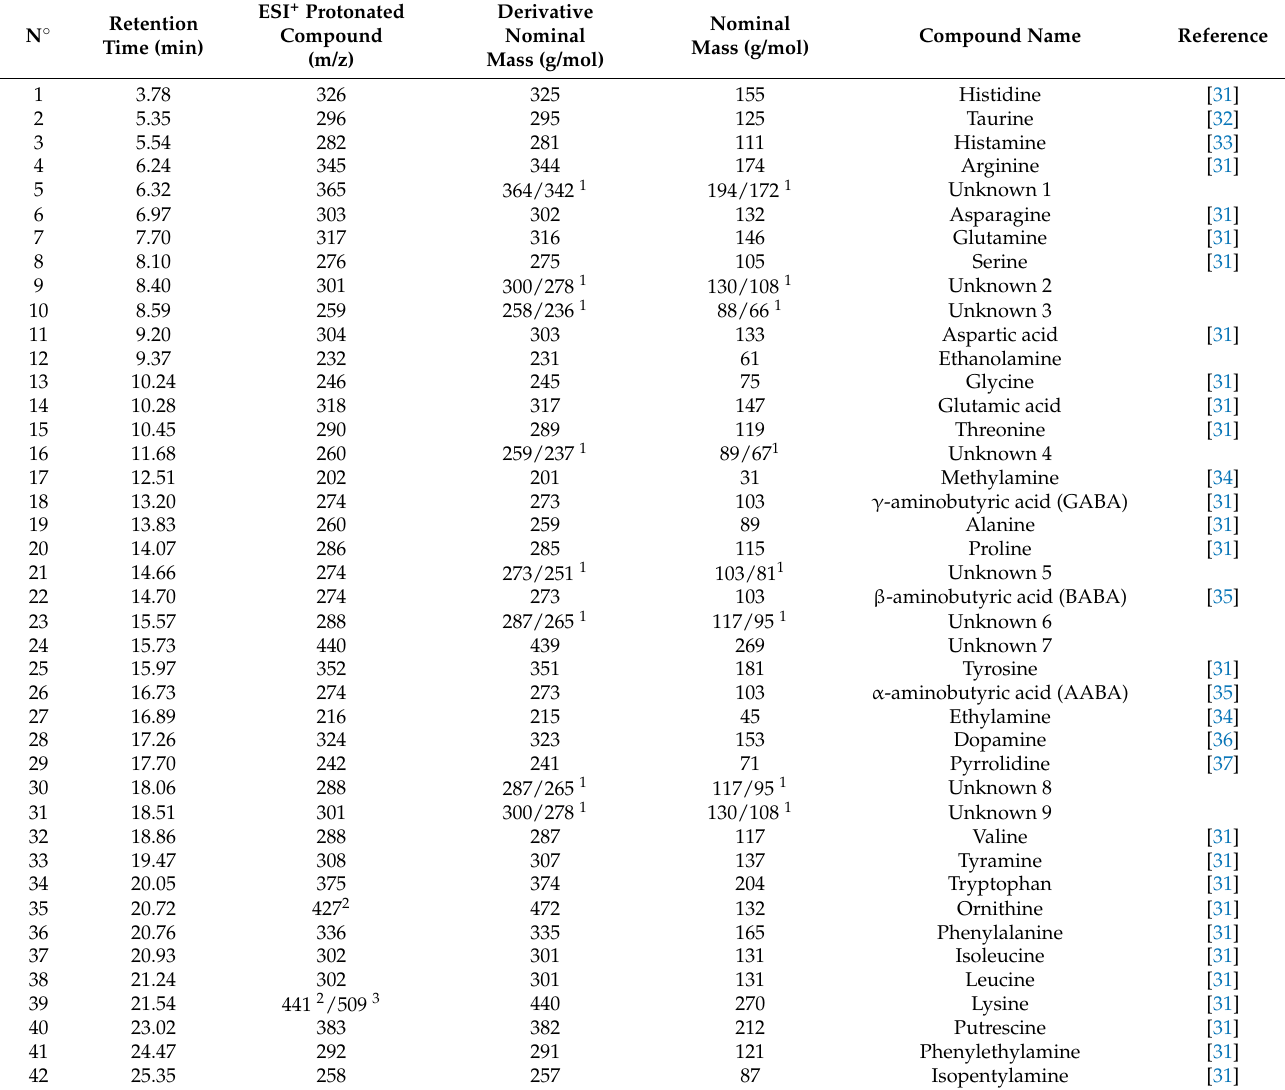
Table 1. Identified amino compounds in Carduus species and Ptilostemon casabonae . Each peak is characterized by retention time, ESI + protonated molecule ( m/z ), DEEM derivative and corresponding amino compound nominal mass (g/mol) and compound names. All the identified compounds were confirmed by the injection of reference